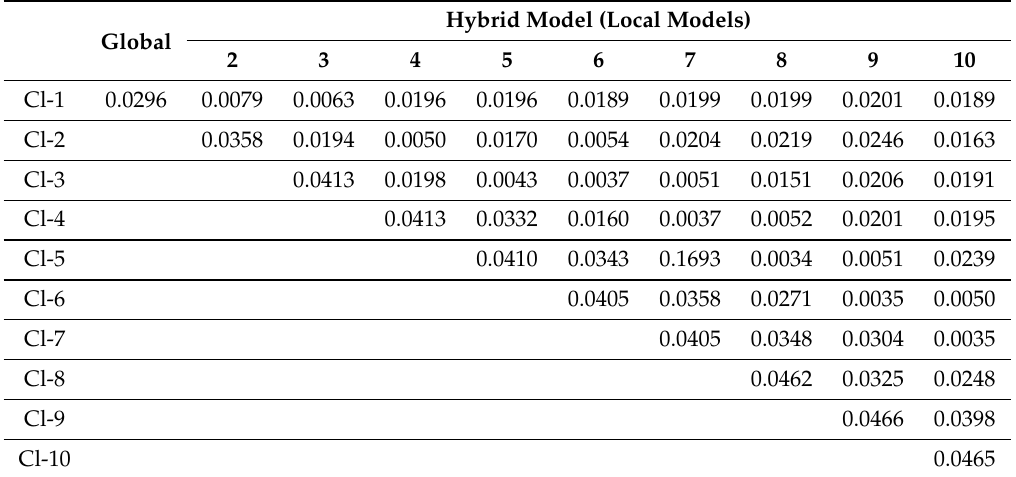
Table 2. Mean absolute error (MAE) using an artificial neural network (ANN) with seven neurons in the hidden layer.